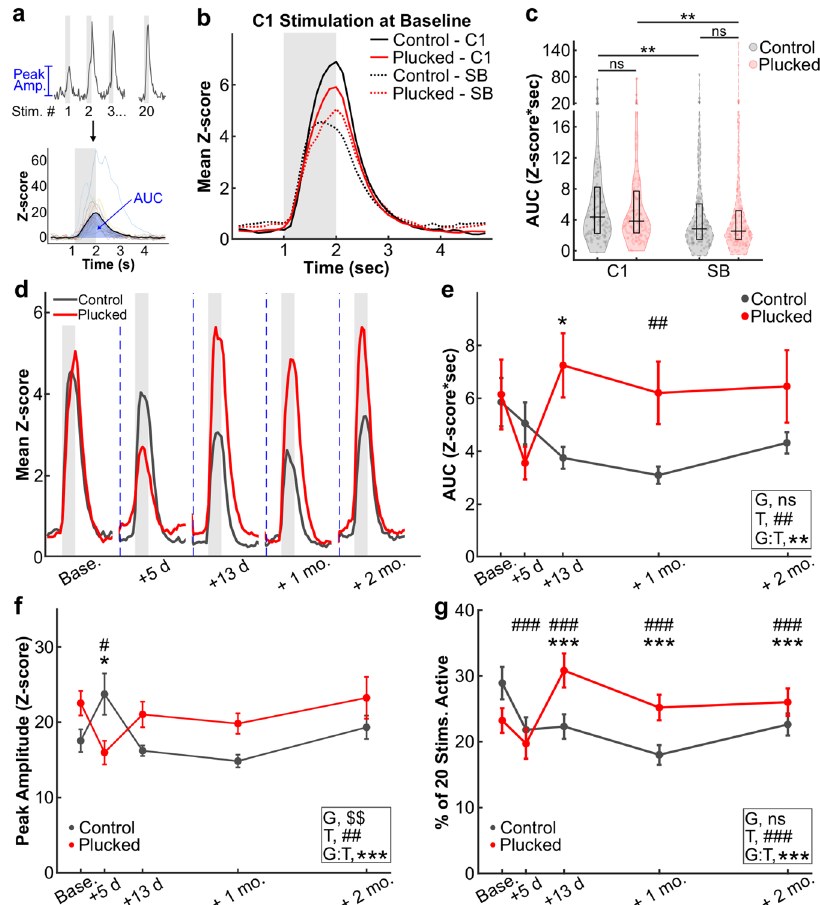
Fig. 6 Forced use therapy after stroke increases the reliability of sensory-evoked responses of neurons in peri-infarct cortex. a Analysis pipeline. Top: neuronal responses to 20 sequential whisker de fl ections at 10Hz were aligned to the onset of the stimulus epoch (gray shading) to generate a mean stimulus- evoked trace per cell. Bottom: individual trials (thin lines) and mean trace (thick line). Peak amplitudes for every stimulus were calculated from individual calcium transients (top), while the area-under-the-curve (AUC) was calculated from the mean stimulus-evoked trace (bottom). b Mean stimulus-evoked response at baseline for all stimulus-locked neurons in control (black) vs. forced use whisker-plucked (red) mice, comparing neurons located in the C1 barrel (C1 — solid lines; n = 121 neurons from 8 control mice and 145 neurons from 10 plucked mice) to those in surround barrels (SB — dashed lines; n = 128 and 146 neurons from the same mice, respectively). Same n applies for c . c Quanti fi cation of the AUC from mean stimulus-evoked responses for all stimulus-locked neurons at baseline. Control group in gray, whisker-plucked group in red. Each dot represents one neuron, horizontal black lines show group medians, and black rectangles show 25 – 75th percentiles. Kruskal – Wallis test with Tukey-Kramer correction for multiple comparisons, ** p <0.01. d Mean stimulus-evoked response from all cells in peri-infarct regions from control (black) or plucked (red) mice over time following stroke. Number of cells ( n )/number of mice ( N ) for control and plucked groups: baseline — 128/8 and 146/10; day 5 — 89/8 and 84/10; day 13 — 165/8 and 110/9; 1 month — 148/8 and 155/10; 2 months — 128/8 and 119/8. Same n applies to e . e Quanti fi cation of the AUC from the mean stimulus-evoked responses from control or plucked mice shown in d . LME model, ANOVA for fi xed effects of group (G, p = 0.646), timepoint (T, ## p = 0.007), and group-by-timepoint interaction (G:T, ** p = 0.003). Signi fi cance for individual coef fi cients for timepoint (T) or group-by-timepoint interaction (G:T), corrected using Benjamini and Hochberg ’ s (B & H) method, are indicated over corresponding data points (* p <0.05; ## p <0.01). Data in e – g represent mean±s.e.m. f Quanti fi cation of peak amplitude of stimulus-evoked responses in stimulus-locked neurons over time following stroke, in control vs. plucked (red) groups. Number of cells ( n )/number of mice ( N ) for control and plucked groups: baseline — 119/8 and 135/10; day 5 — 85/8 and 75/10; day 13 — 152/8 and 104/9; 1 month — 135/8 and 146/10; 2 months — 123/8 and 112/8. LME model, ANOVA for fi xed effects of group (G, $$ p = 0.003), timepoint (T, ## p = 0.002) and group-by-timepoint interaction (G:T, *** p <0.001). Signi fi cance for individual coef fi cients for timepoint (T) or group-by-timepoint interaction (G:T), corrected using B & H method, are indicated over corresponding data points (* or #p< 0.05). g Quanti fi cation of the percentage of whisker stimuli that stimulus-locked neurons respond to over time following stroke, in control vs. plucked groups. n / N for control and plucked groups: baseline — 128/8 and 146/10; day 5 — 89/8 and 84/10; day 13 — 165/8 and 110/9; 1 month — 148/8 and 155/10; 2 months — 128/8 and 119/8. GLME binomial model, ANOVA for fi xed effects of group (G, p = 0.054), timepoint (T, ### p <0.001) and group-by- timepoint interaction (G:T, *** p <0.001). Signi fi cance for individual coef fi cients for timepoint (T) or group-by-timepoint interaction (G:T), corrected using B & H method, are indicated over corresponding data points (*** or ### p